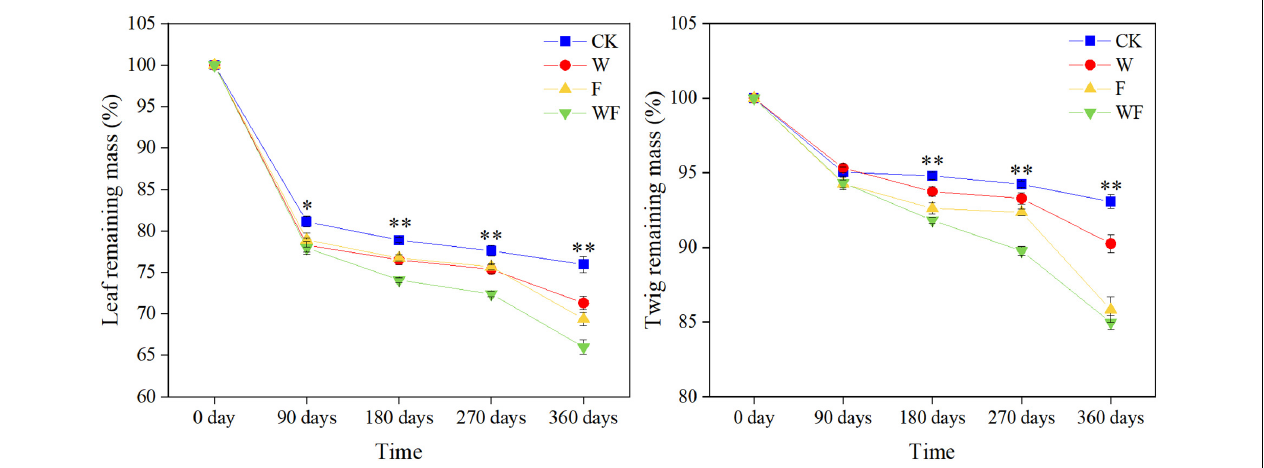
Figure 5 | Percentages of remaining mass in leaf and twig under different treatments during the experimental period. The P-value showed the results from one-way ANOVA testing for the effects of dry-season irrigation and fertilization, ∗ P < 0.05, ∗∗ P < 0.01. TABLE 4 | Pearson correlation analysis between litter remaining mass (leaf and twig) and initial chemical traits. Time